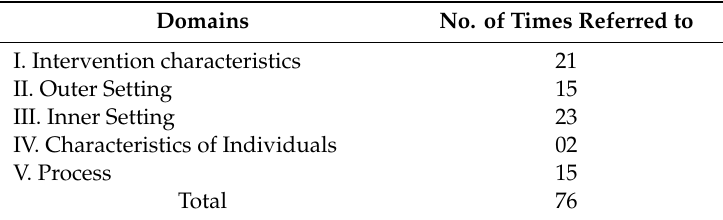
Table 4. CFIR Domains referred to in